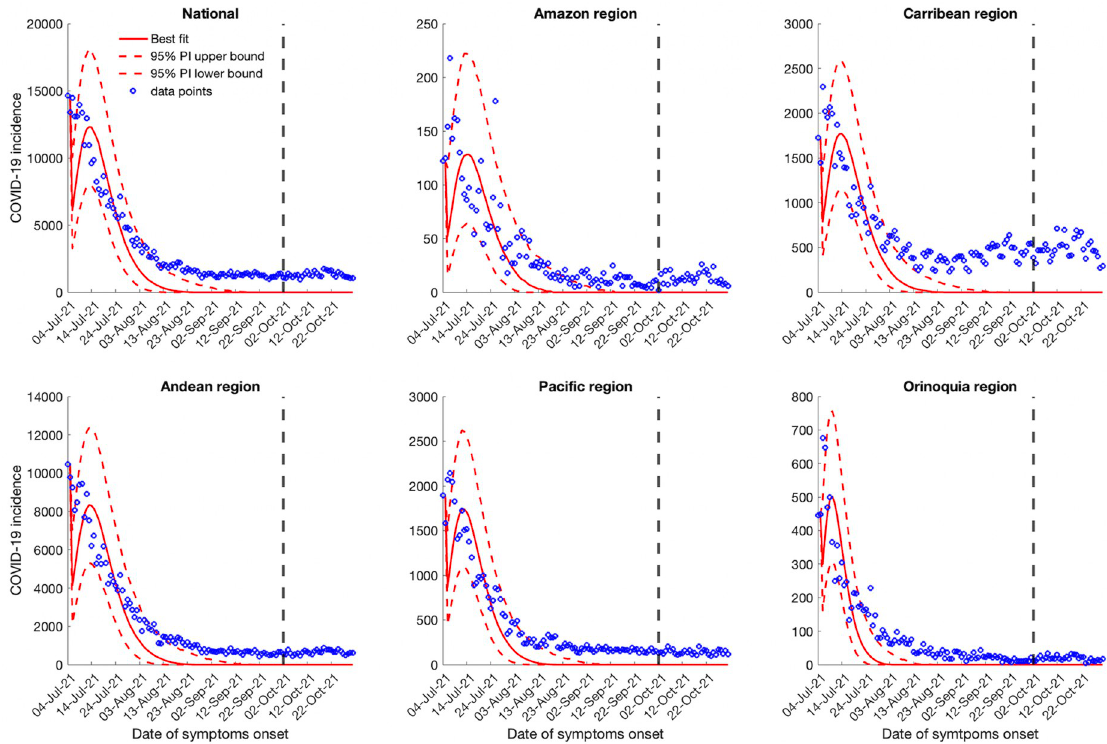
Fig 4. 30-days ahead forecast of the national and regional COVID-19 epidemic curves in Colombia by calibrating the Richards model from July 4, 2021 to October 1, 2021. The blue circles correspond to the data points; the solid red line indicates the best model fit, and the red dashed lines represent the 95% prediction interval. The vertical black dashed line represents the time of the start of the forecast